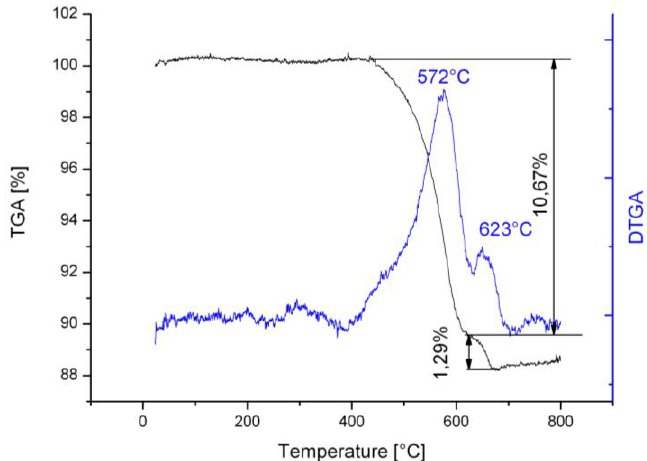
Figure 4. Thermogravimetric analysis (TGA) and DTGA diagrams of the nanostructured clinker with two clearly visible mass loss